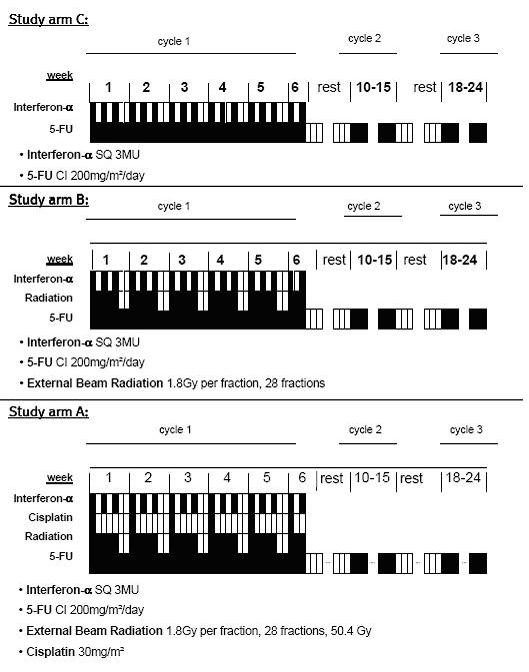
Treatment scheme.